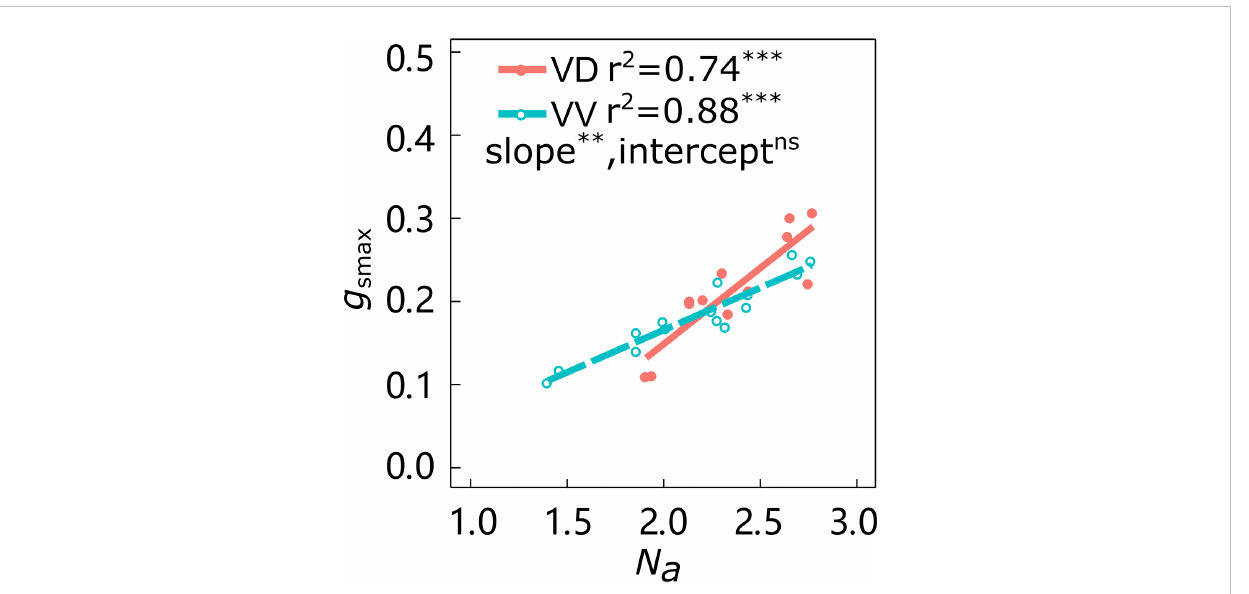
FIGURE 2 Relationships between leaf nitrogen content per area ( N a ) and maximum stomatal conductance ( g smax ) of ‘ Gala ’ apple trees grafted on vigorous rootstocks and associated with either a dwarf M26 interstock (VD) or a vigorous ‘ Qinguan ’ interstock (VV). Linear regression coef fi cients (r 2 ) and signi fi cance for the regression slope and intercept are shown when P < 0.01 with ** and P < 0.001 with *** and ns means no signi fi cant difference between